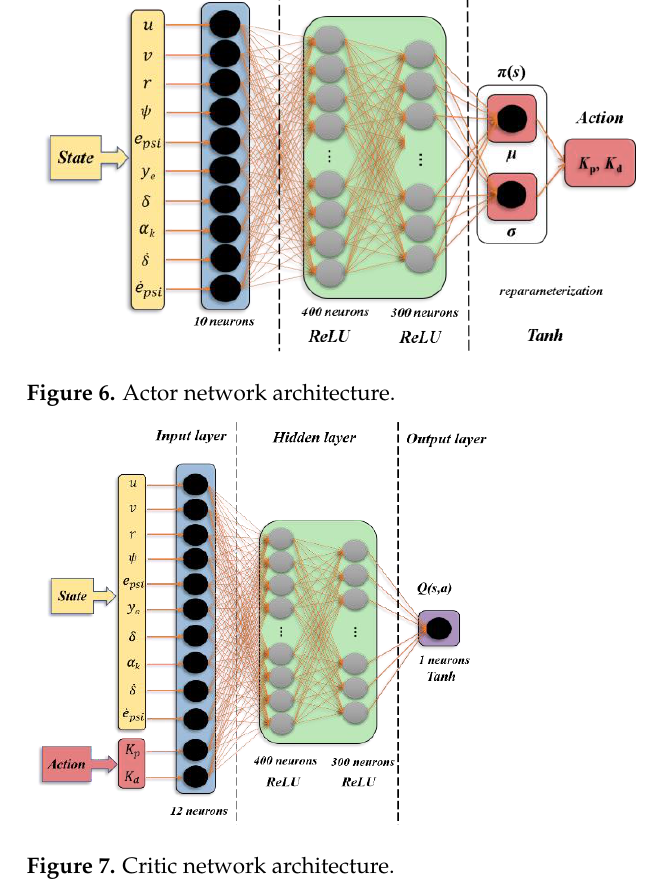
Table 3. Hyperparameters of the